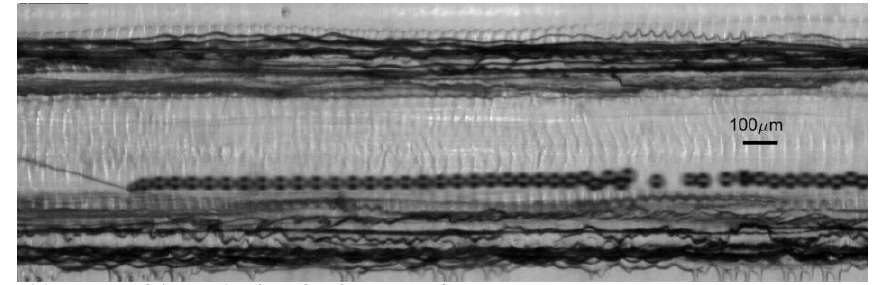
Figure 12. Process of bubble generation with the hybrid microfluidic device with hybrid microfluidic device, production rate of approximately 1800 s − 1 bubbles. Gas pressure at 1.04 bar and liquid flow in 1.55 mL·min − 1 .